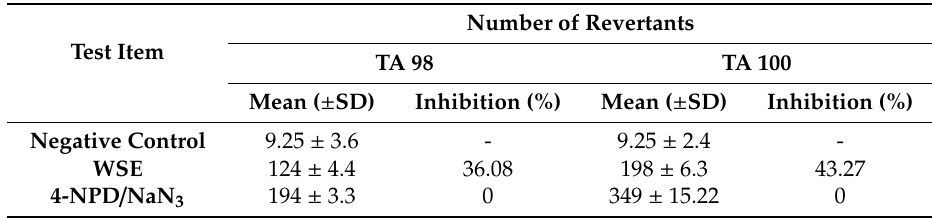
Table 5. Antimutagenity assay for Salmonella typhimurium TA 98 and TA 100